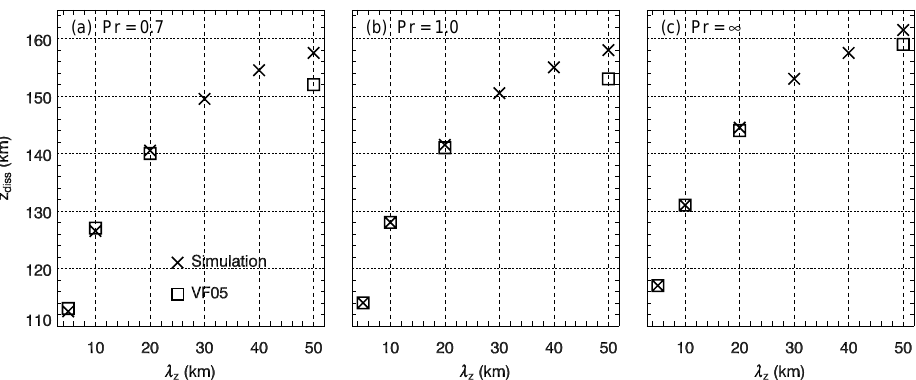
Fig. 7. GW dissipation altitudes ( z diss ) calculated from our numerical simulations for GWs with different initial wavelengths (cross, ×). The Prandtl numbers for Fig. 6a, b and c are 0.7, 1.0 and ∞ , respectively. We also overlap the VF05 results (taken from Table 1 of VF05) (square, (cid:3)